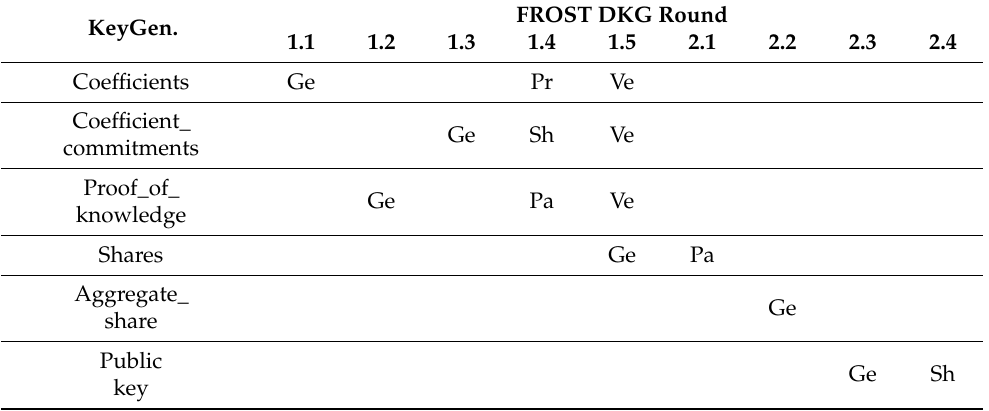
Table 1. Created items by distributed key generation round. KeyGen.